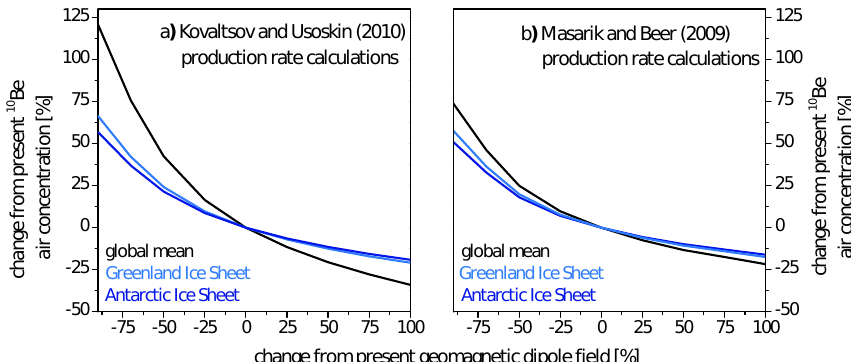
Figure 3. Modeled influence of the geomagnetic dipole field changes on atmospheric 10 Be illustrating the effect of atmospheric mixing. The left and right panel differ in the production rate calculations applied in the model simulations; (a) Kovaltsov and Usoskin (2010) or (b) Masarik and Beer (2009). Different lines show the global mean 10 Be air concentration (black) and local 10 Be air concentration on the Greenland (light blue) and Antarctic (deep blue) ice sheet. Solar activity is held constant at 550MV. Note that the uncertainty of aerosol sink calibration (shown in Fig. 1) does not significantly influence the above